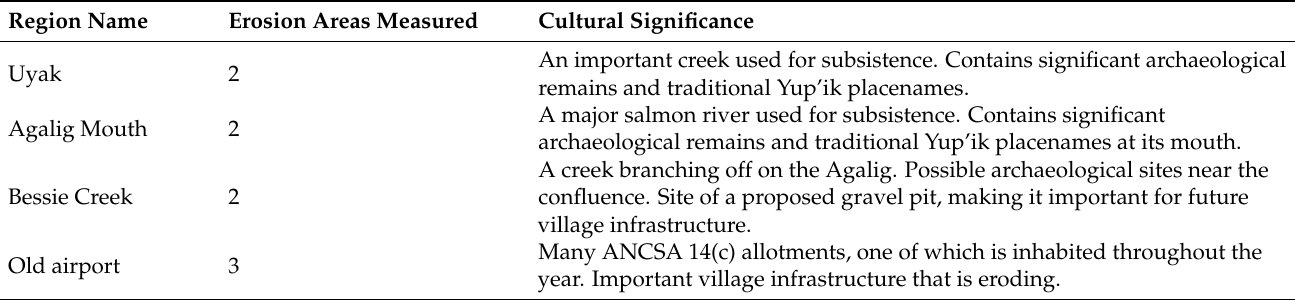
Table 1. Regions measured using UAV surveys in 2022 and archival satellite